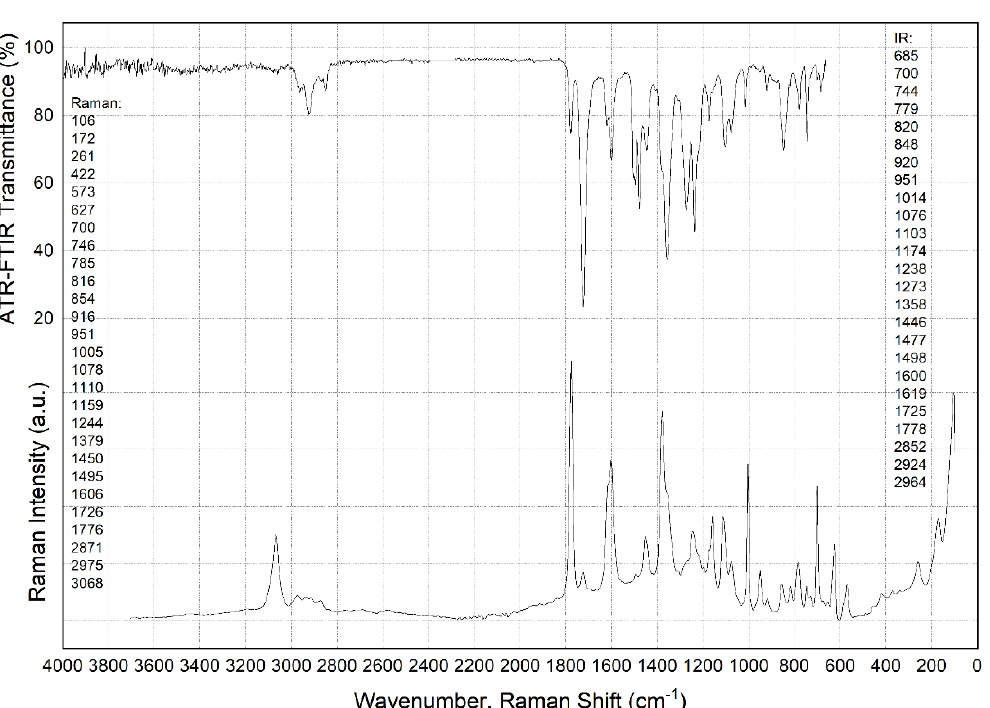
Figure 3. The FTIR and Raman spectra for neat PI.